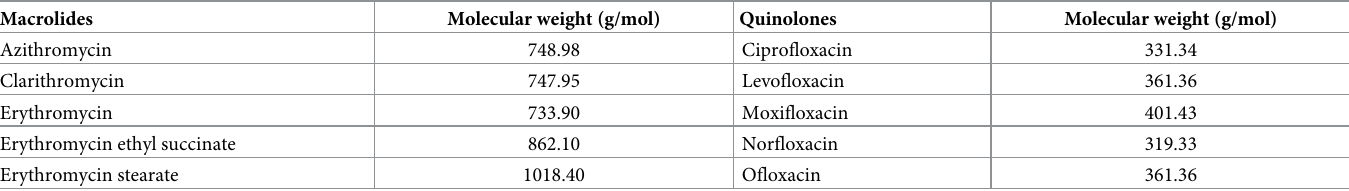
Table 2. Molecular weights of macrolides and fluoroquinolones.